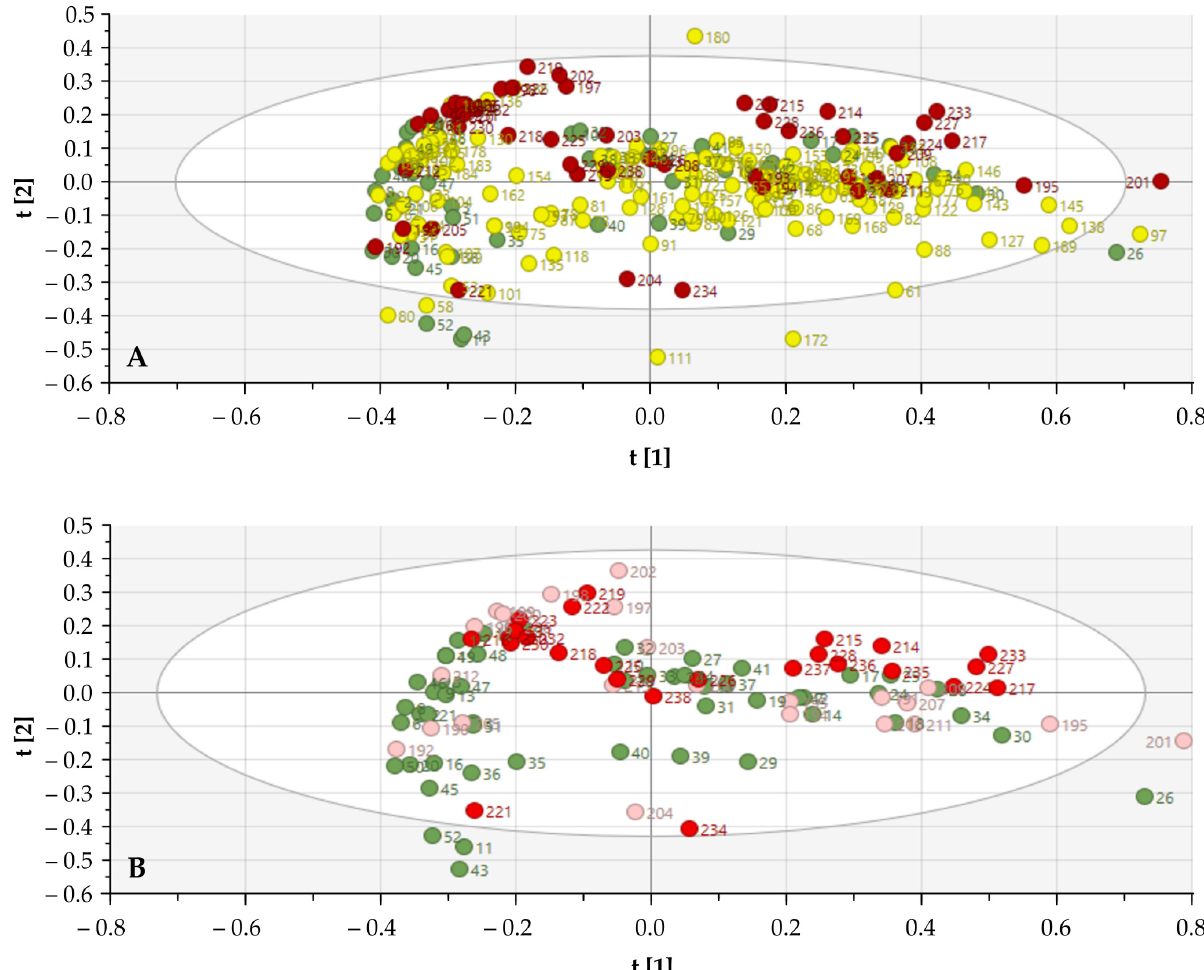
Figure 2. Score plots of all NIR spectra for differentiation of salivary gland specimens. ( A ) Score plot of all tissue samples according to the oncological classification (control (green), benign (yellow), and malignant (red)). ( B ) Score plots according to malignant histological classification (control (green); acinic cell carcinoma, mammary analogue salivary carcinoma, and adenoid cystic carcinoma (light red); and epithelial myoepithelial carcinoma, mucoepidermoid carcinoma, and salivary duct carcinoma (dark red)).